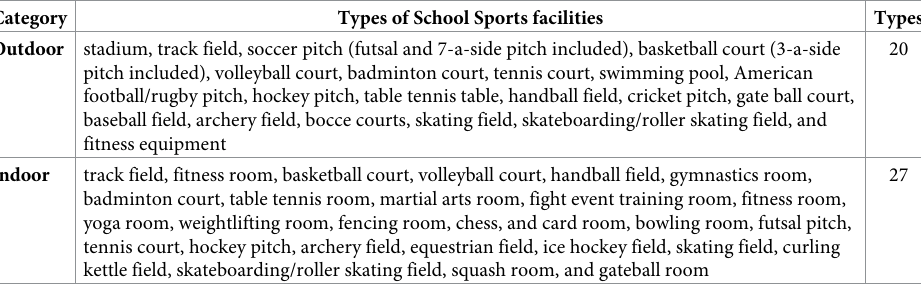
Table 2. Classification and types of school sports facilities